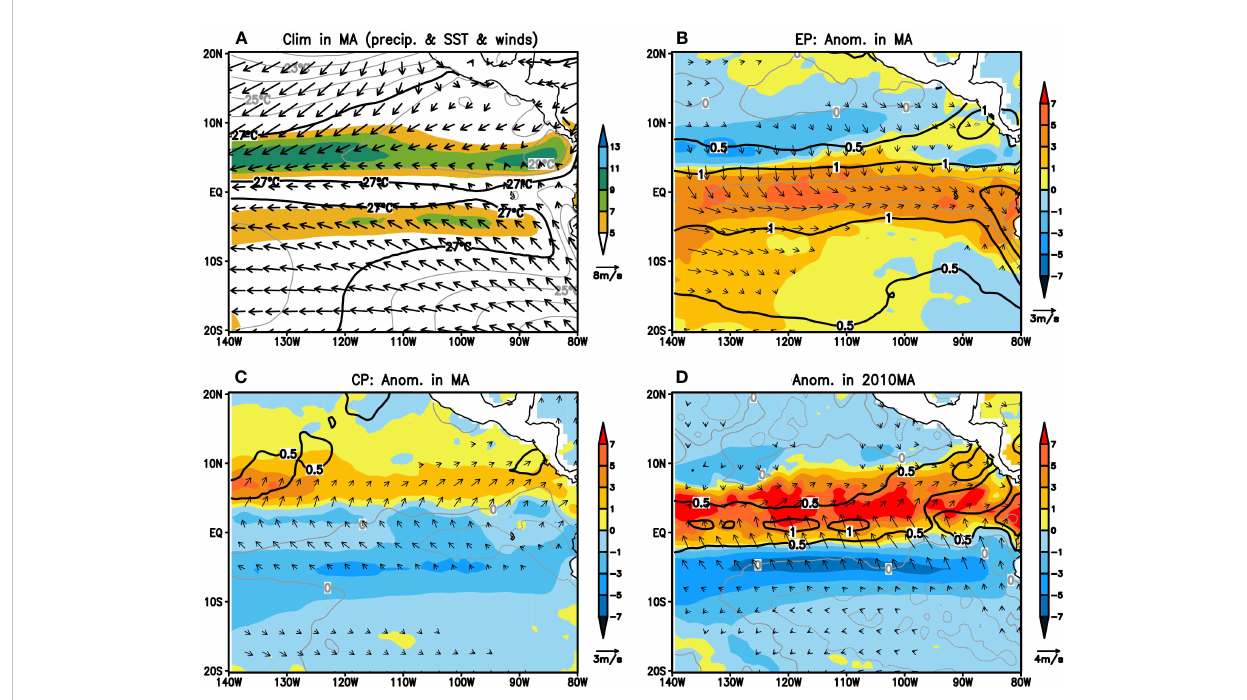
FIGURE 5 (A) Climatology in March-April: spatial pattern of the precipitation (color shaded; units: mm/day), SST (contours; units: °C), and surface winds (vectors; units: m/s; wind speed smaller than 1 m/s has been masked out) over the tropical eastern Paci fi c Ocean. Anomalies of precipitation, SST and surface winds (wind speed smaller than 0.5 m/s has been masked out) for: (B) the composite of EP-type El Niños; (C) the composite of CP-type El Niños and (D) the 2009/2010 mixed-type El Niño.